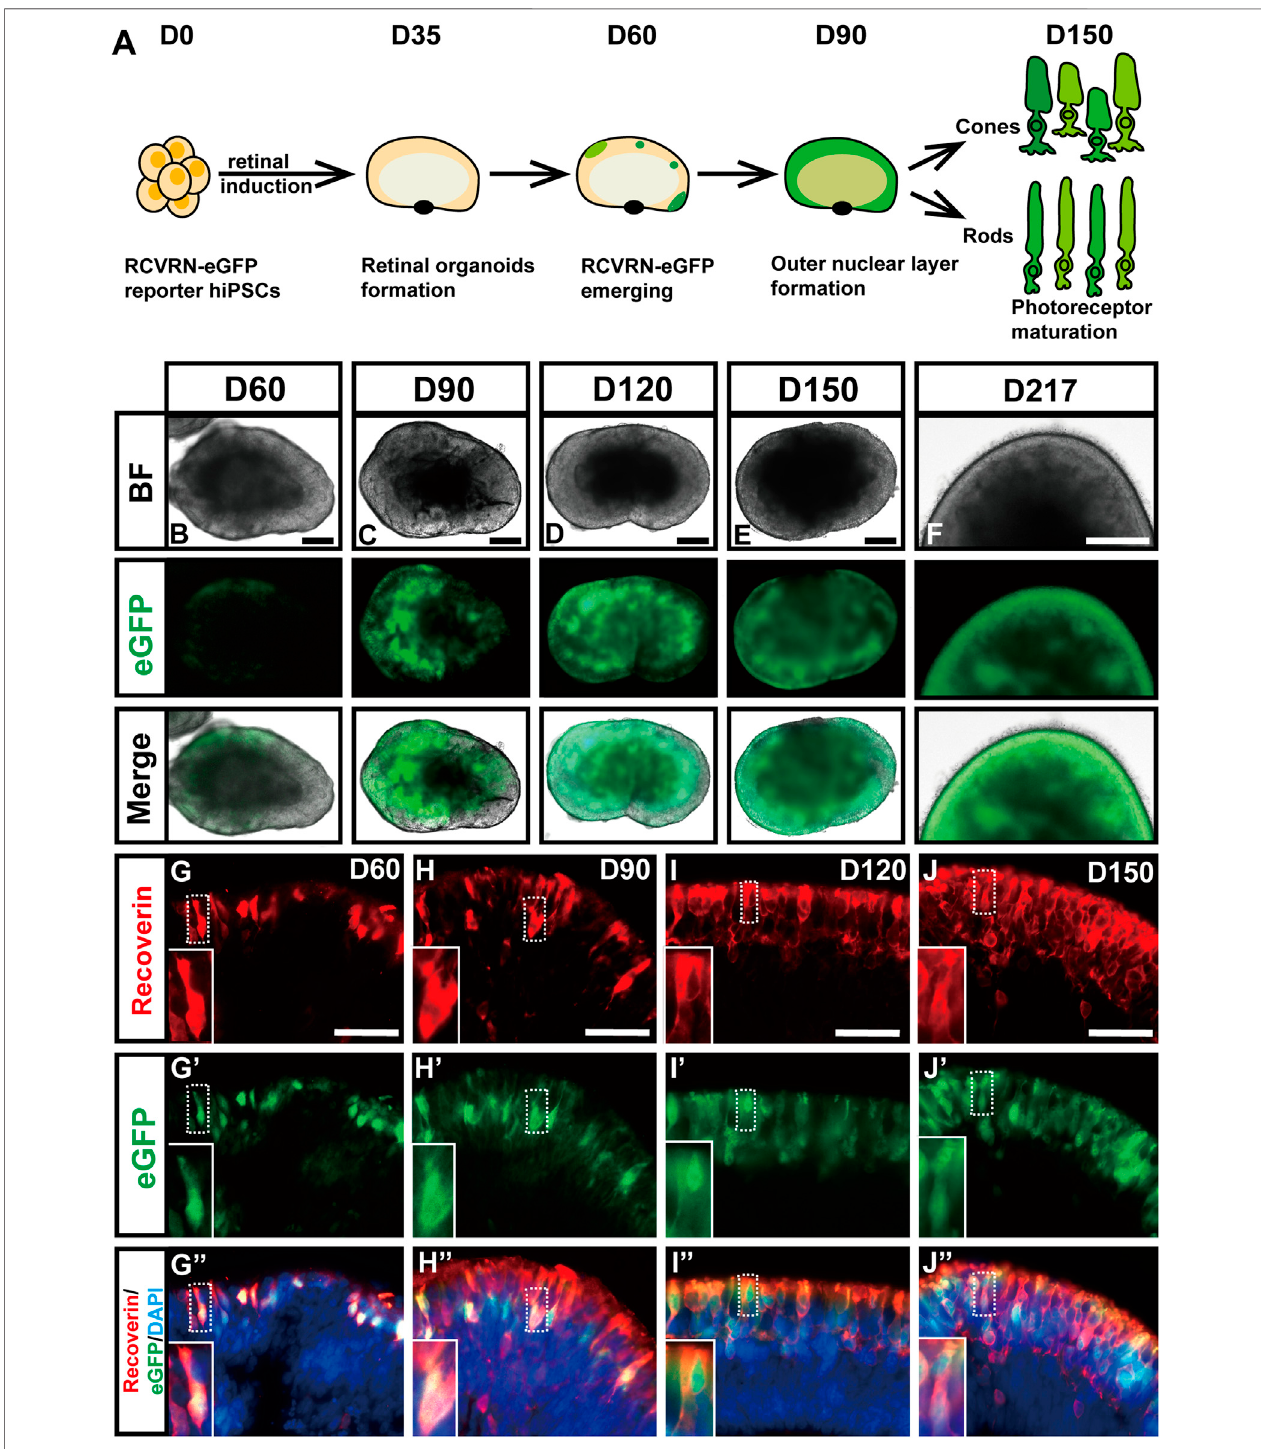
FIGURE 2 | Validating the faithfulness and robustness of RCVRN-eGFP during retinal induction. (A) Timeframe of the expression of the RCVRN-eGFP (eGFP) in retinal organoids (ROs). (B – F) Bright- fi eld (BF) and fl uorescent images showed the expression patterns of eGFP in ROs over time. (G – J ” ) Immuno fl uorescence images showed the co-localization of eGFP and endogenous recoverin in ROs at different time points. Nuclei were stained with DAPI. Scale bars, 200 μ m (B – F); 50 μ m (G-J ″ ).